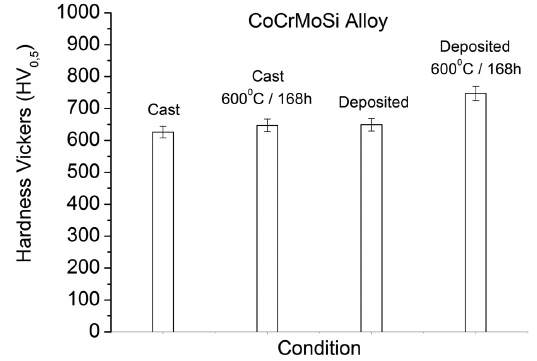
Figure 2. Hardness for as processed and after temperature exposure conditions.